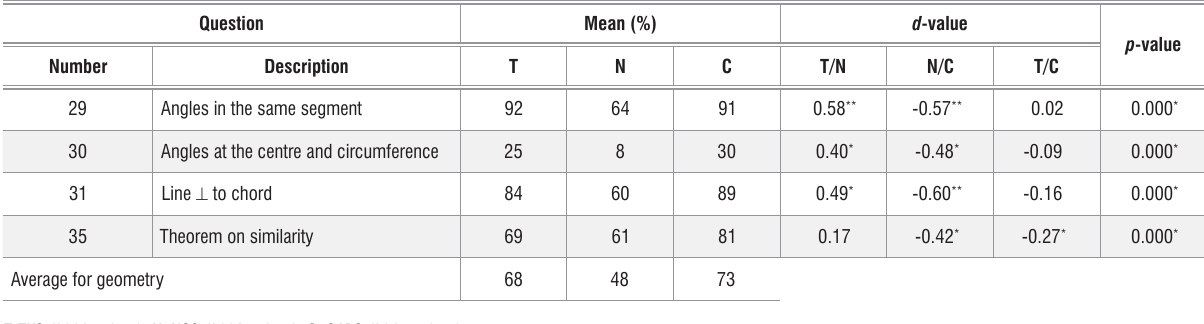
Question by question comparison for geometry